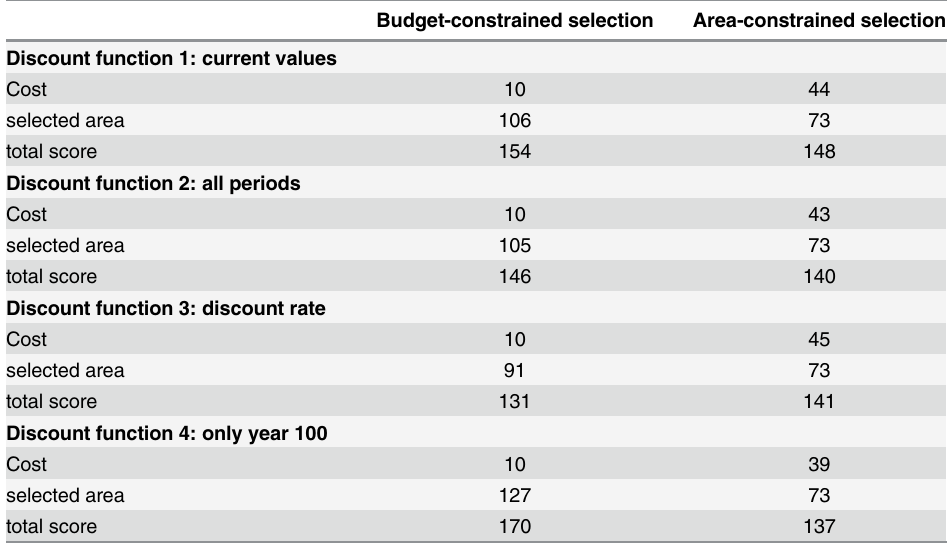
Table 3. The total cost (billion SEK), area selected (10 000 ha), and total indicator scores over 100 years (10 million points) of selections yielded by models incorporating the four variants of the dis- count function for the budget -constrained selections and area-constrained